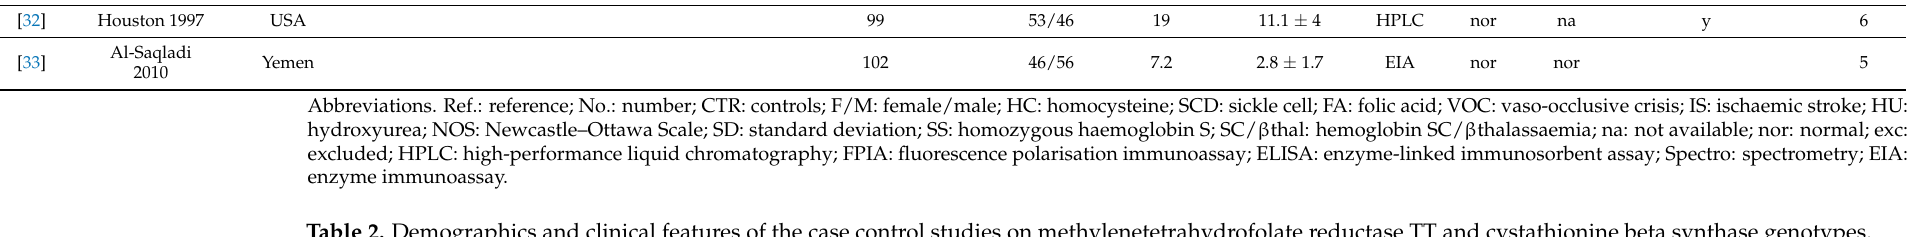
Table 2. Demographics and clinical features of the case control studies on methylenetetrahydrofolate reductase TT and cystathionine beta synthase genotypes.